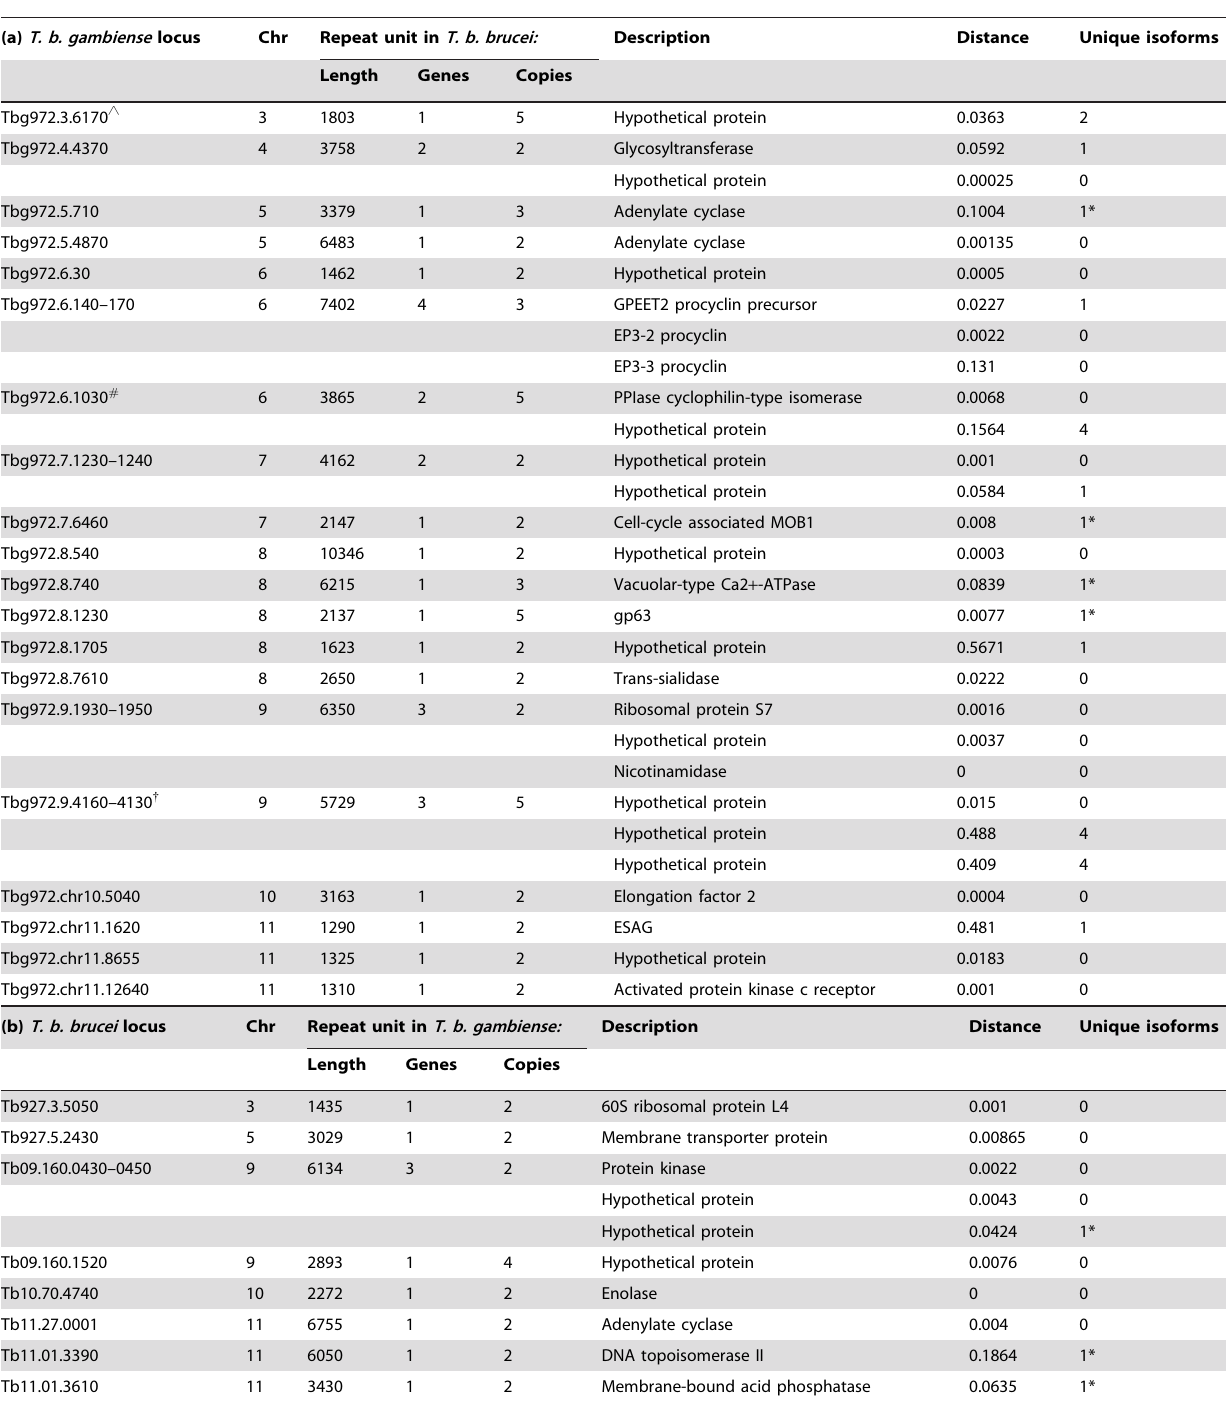
Table 1. Species-specific segmental duplications in (a) T. b. gambiense and (b) T. b. brucei.